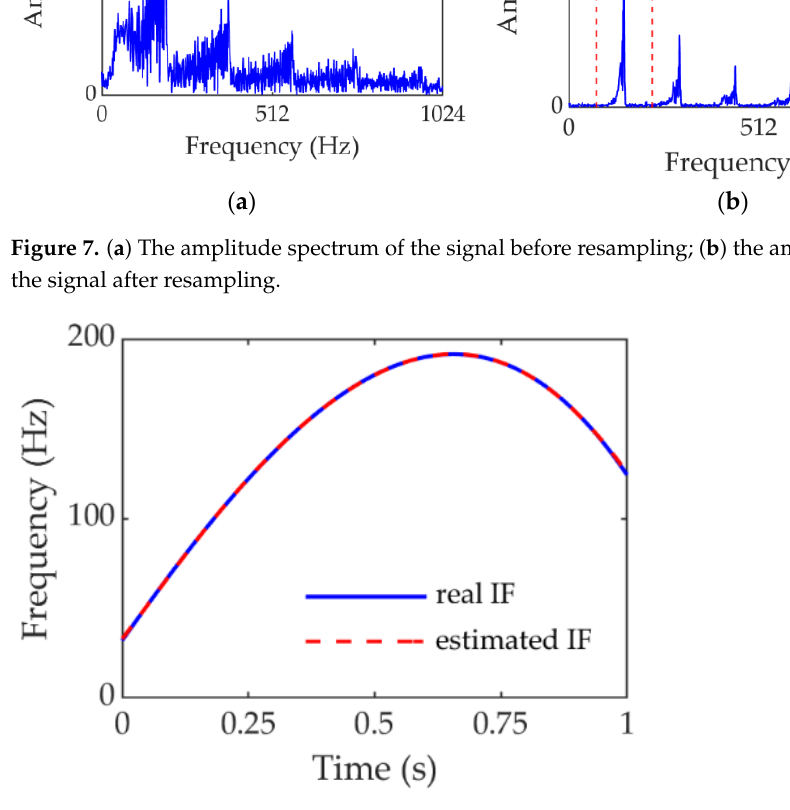
Figure 8. The estimated IF compared with the real IF of the separated fundamental harmonic.